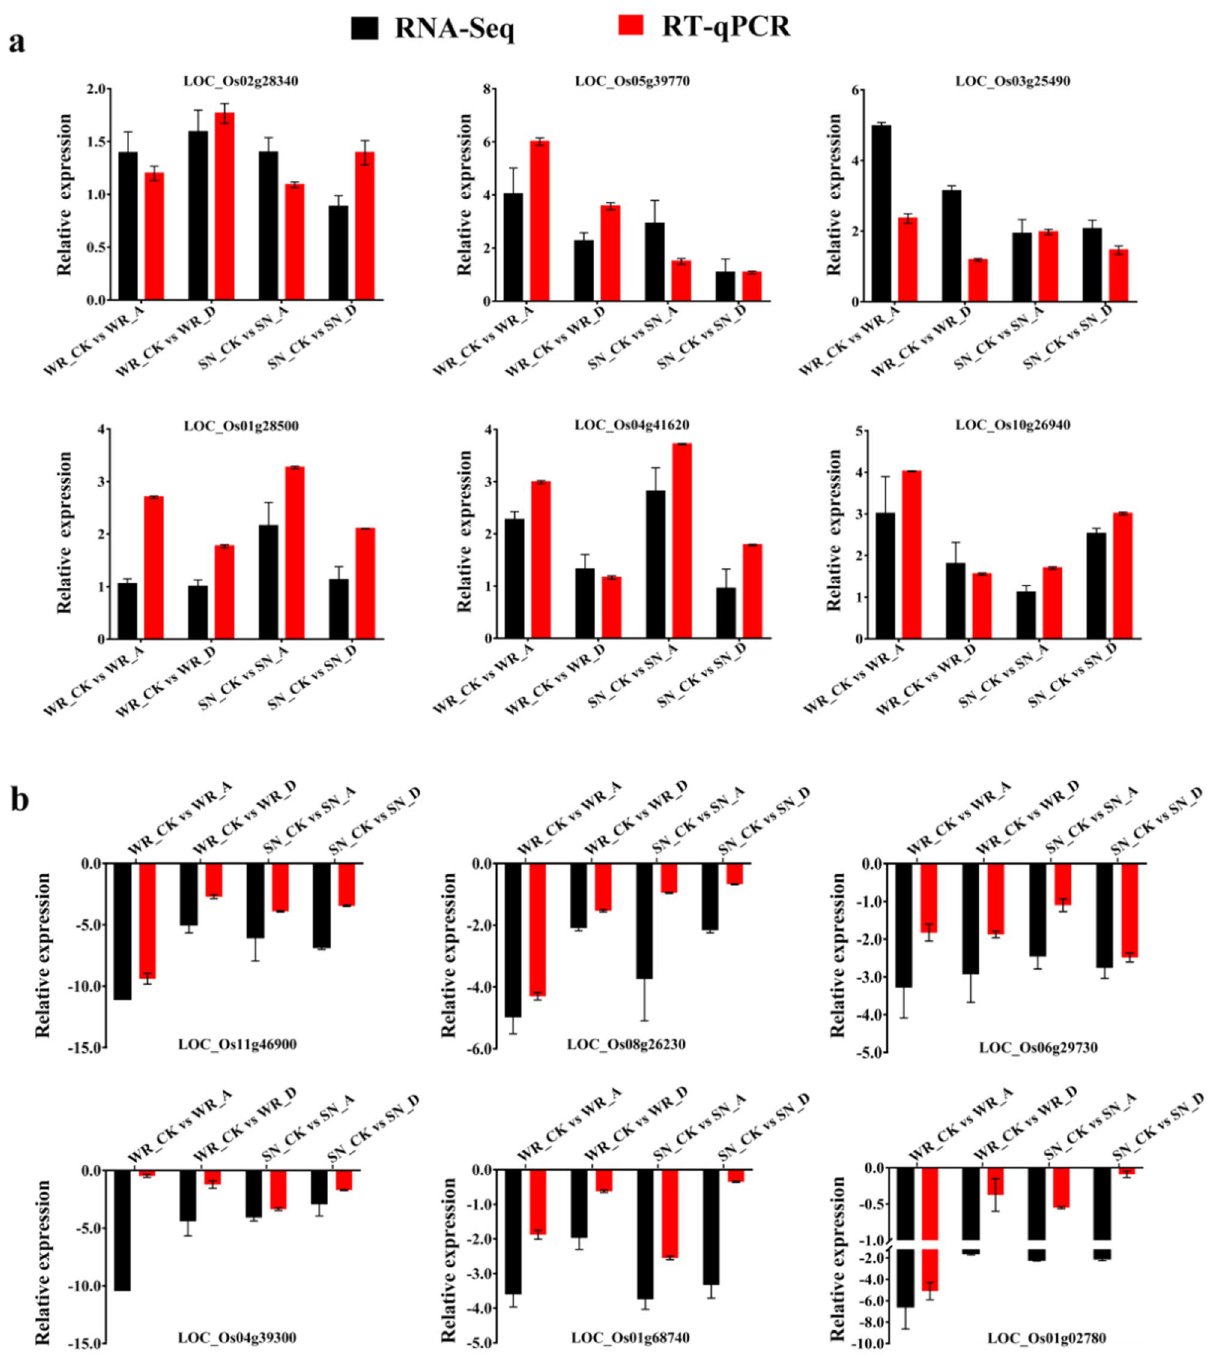
Figure 8. Comparison of relative expression level of twelve genes by RNA-Seq and RT-qPCR. ( a ) up-regulated genes; ( b ) down-regulated genes. Black and red bas represent relative expression level from FPKM and RT-qPCR, respectively. Error bars represent SEs (n =